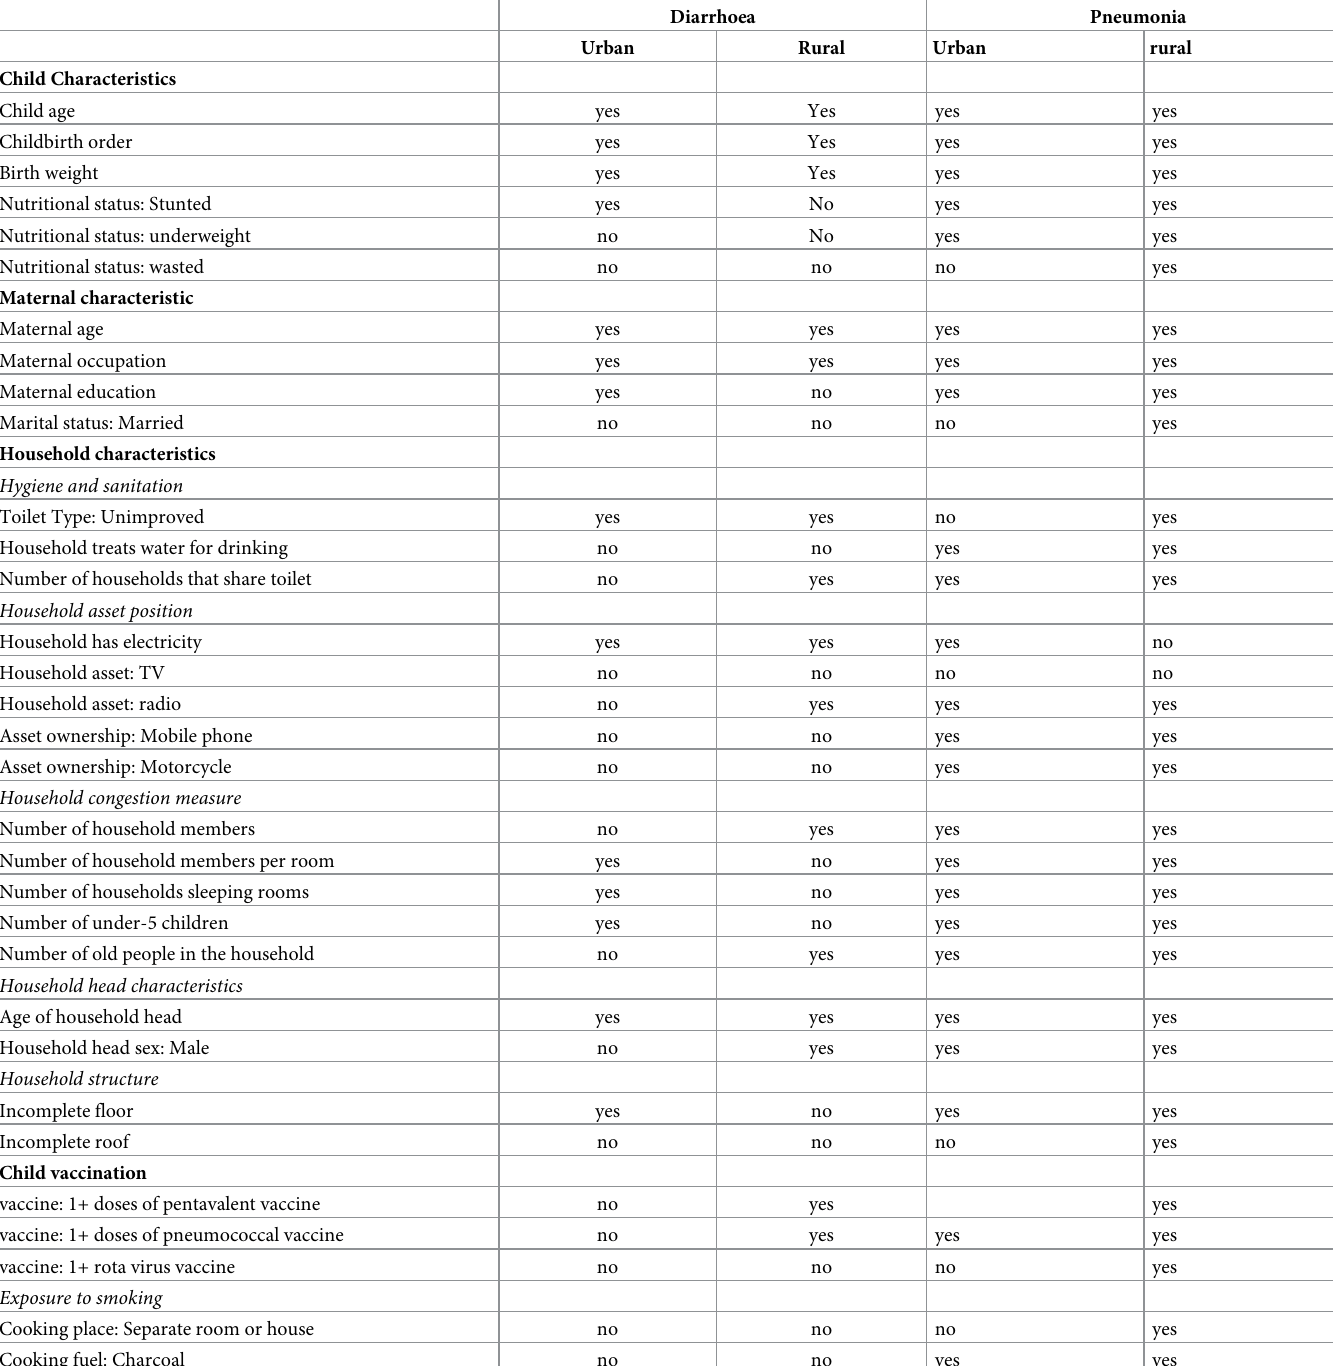
Table 6. Differences in identified predictors of pneumonia and diarrhoea between the places of